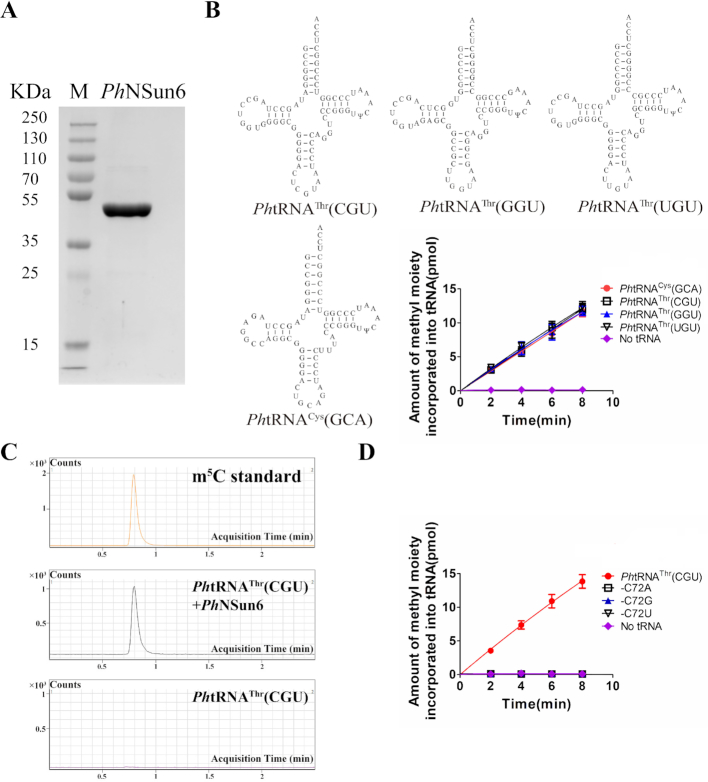

PhNSun6 catalyzes m5C72 modification on PhtRNACys(GCA) and three PhtRNAThr isoacceptors in vitro. (A) SDS-PAGE analysis of the purified PhNSun6, as indicated. Standard molecular weights were shown on the left. (B) The capacity of PhtRNACys(GCA) and PhtRNAThrs to be methylated by PhNSun6. (C) PhtRNAThr(CGU) incubated with or without PhNSun6 were digested and detected by mass spectrum. (D) None of PhtRNAThr(CGU)-C72 mutants could be methylated by PhNSun6. Error bars represent the standard errors of three independent experiments in Figures 1–4.